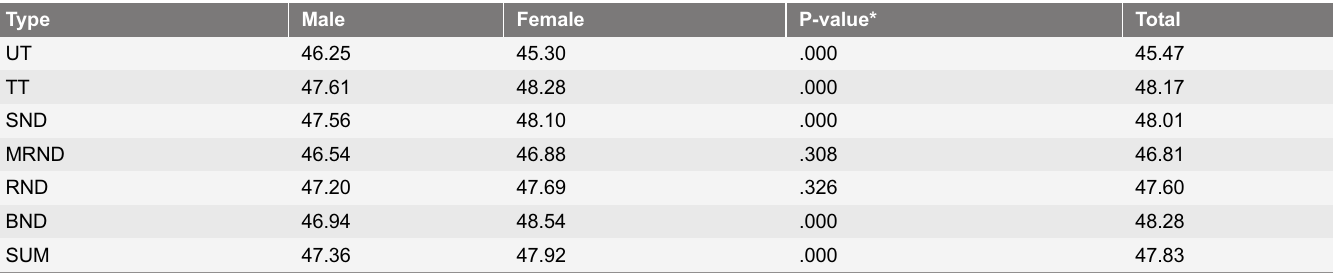
Table 3. Mean age of patients undergoing each type of